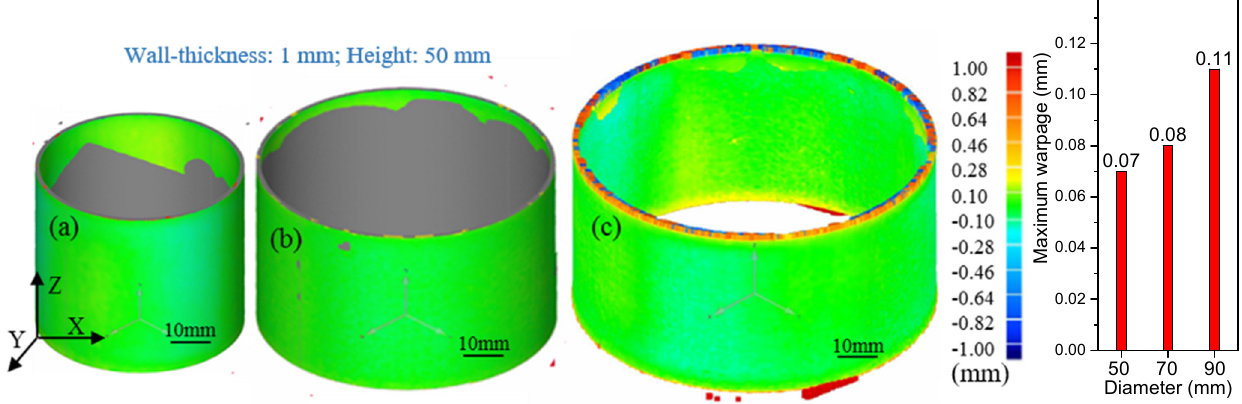
Figure 6. Contour-fills of the final warpage of the cylindrical thin-wall structures with different diameters of: ( a ) 50 mm; ( b ) 70 mm; ( c ) 90mm; ( d ) Maximum warpages recorded in the middle section.